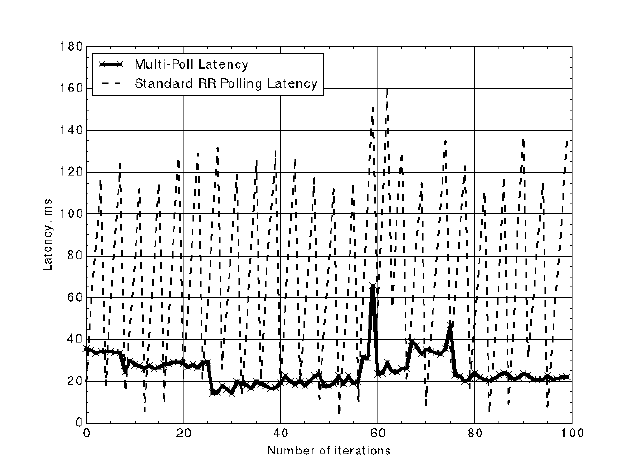
Fig. 7. User’s latency under standard polling and multi-polling conditions. When total of 80 clients are connected to AP.